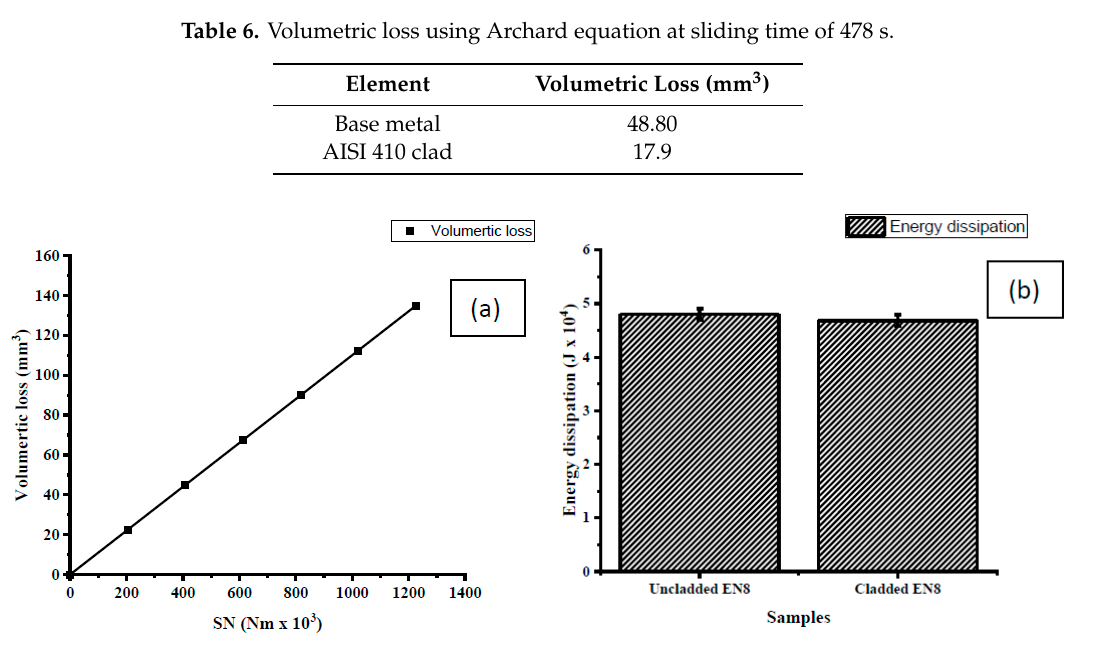
Table 6. Volumetric loss using Archard equation at sliding time of 478 s.